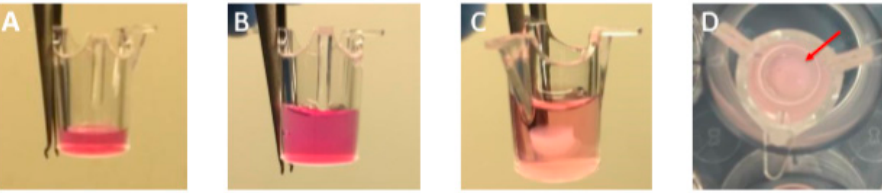
Figure 2. Steps for setting a 3D GTE. The images represent an example of ( A ) acellular collagen; ( B ) collagen-embedded iHGF; ( C ) the mucosal component iHGK addition; ( D ) successful GTE culti- iHGF; ( C ) the mucosal component iHGK addition; ( D ) successful GTE cultivated for 25 days (15 days of vated for 25 days (15 days of airlift).